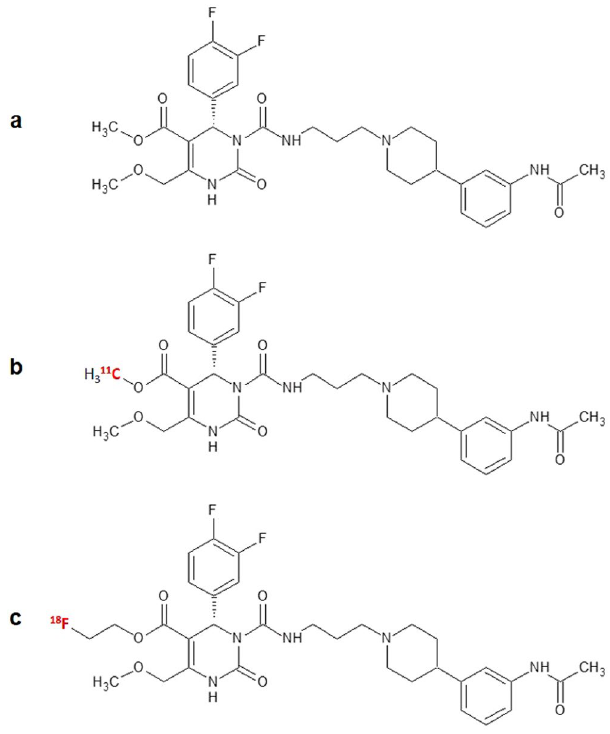
Figure 1. Chemical structures of the MCHR1 antagonists. Chemical Structures of ( + )-SNAP-7941 ( a ), [ 11 C] SNAP-7941 ( b ) and [ 18 F]FE@SNAP (c) . The red colored atom indicates the position of the radioisotope introduced by